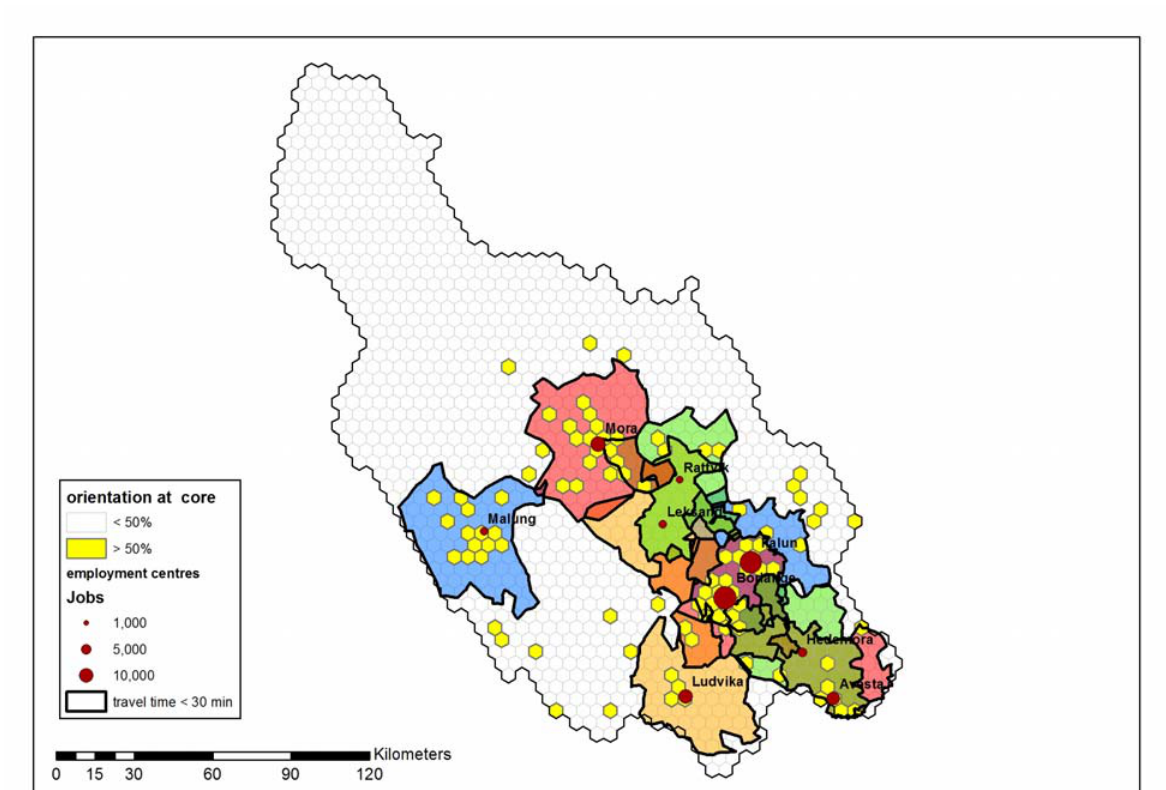
Figure 9. Commuting fields and 30 min travel time